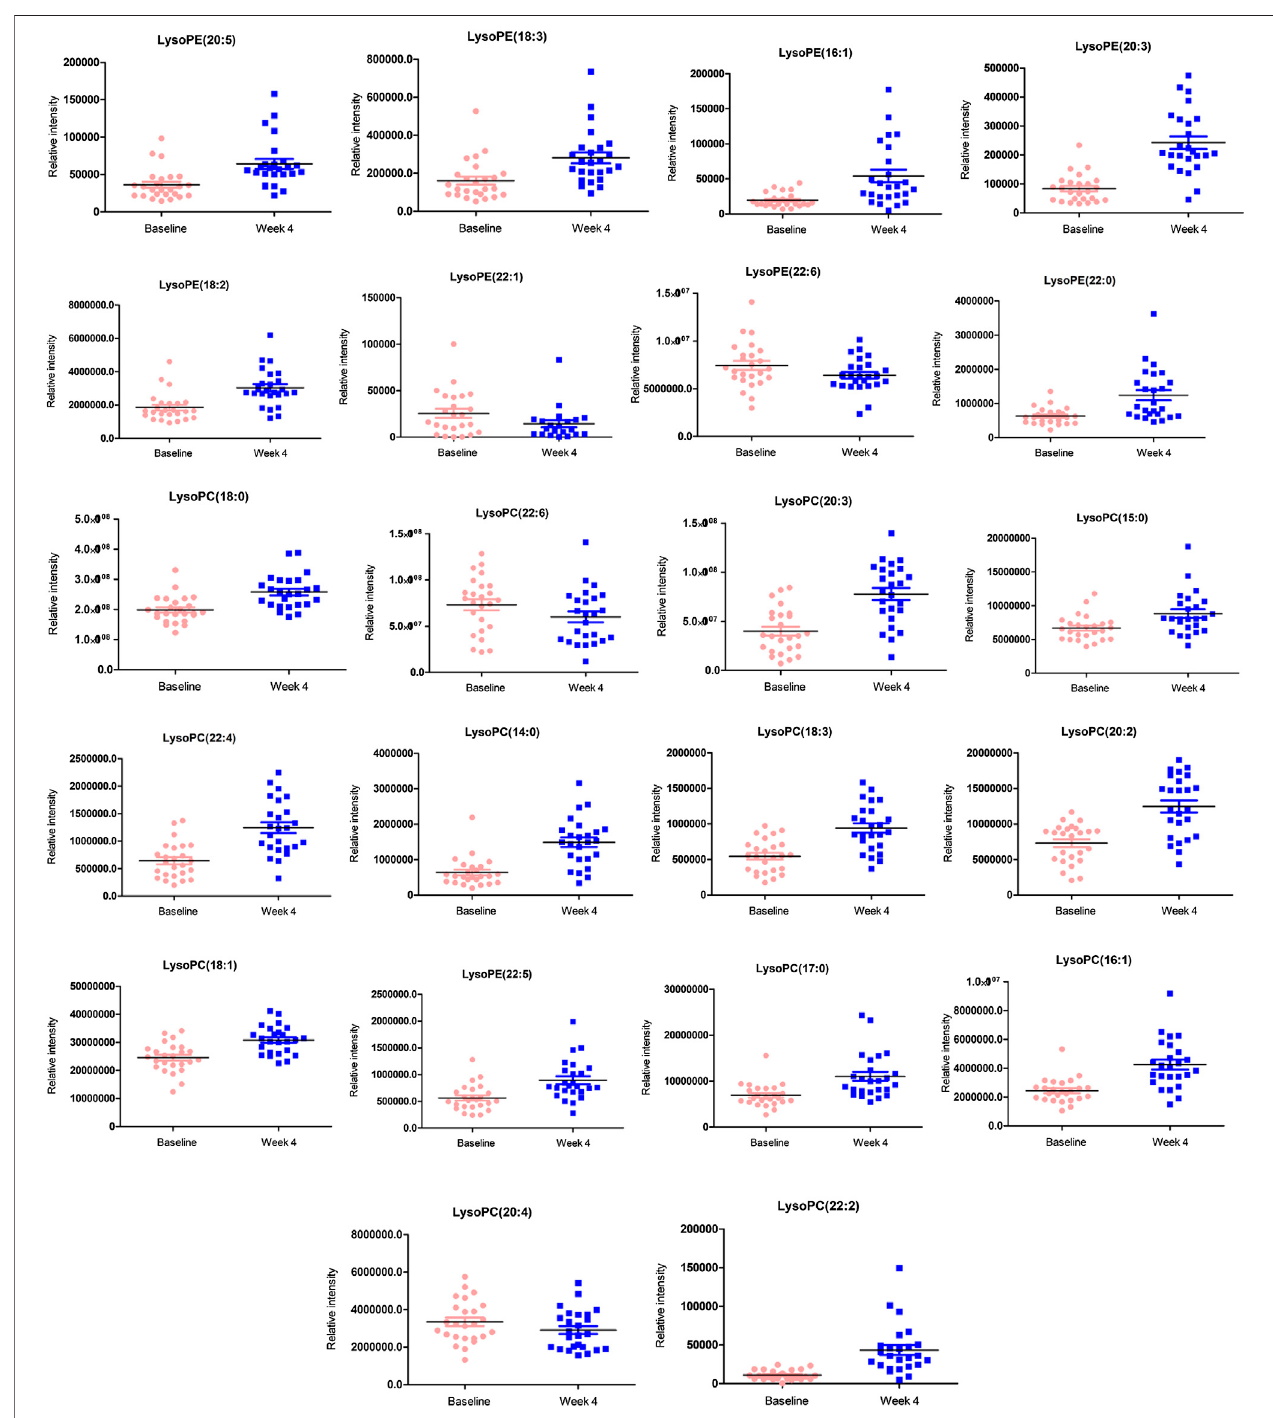
FIGURE 1 | This fi gure presents the boxplots of the metabolite levels at baseline and at follow-up after treatment with olanzapine for 1 mo. The sample means are indicated by the black bars. The levels of most lysophosphatidylcholine (LPC) and lysophosphatidylethanolamine (LPE) were signi fi cantly increased after treatment with olanzapine (all p <